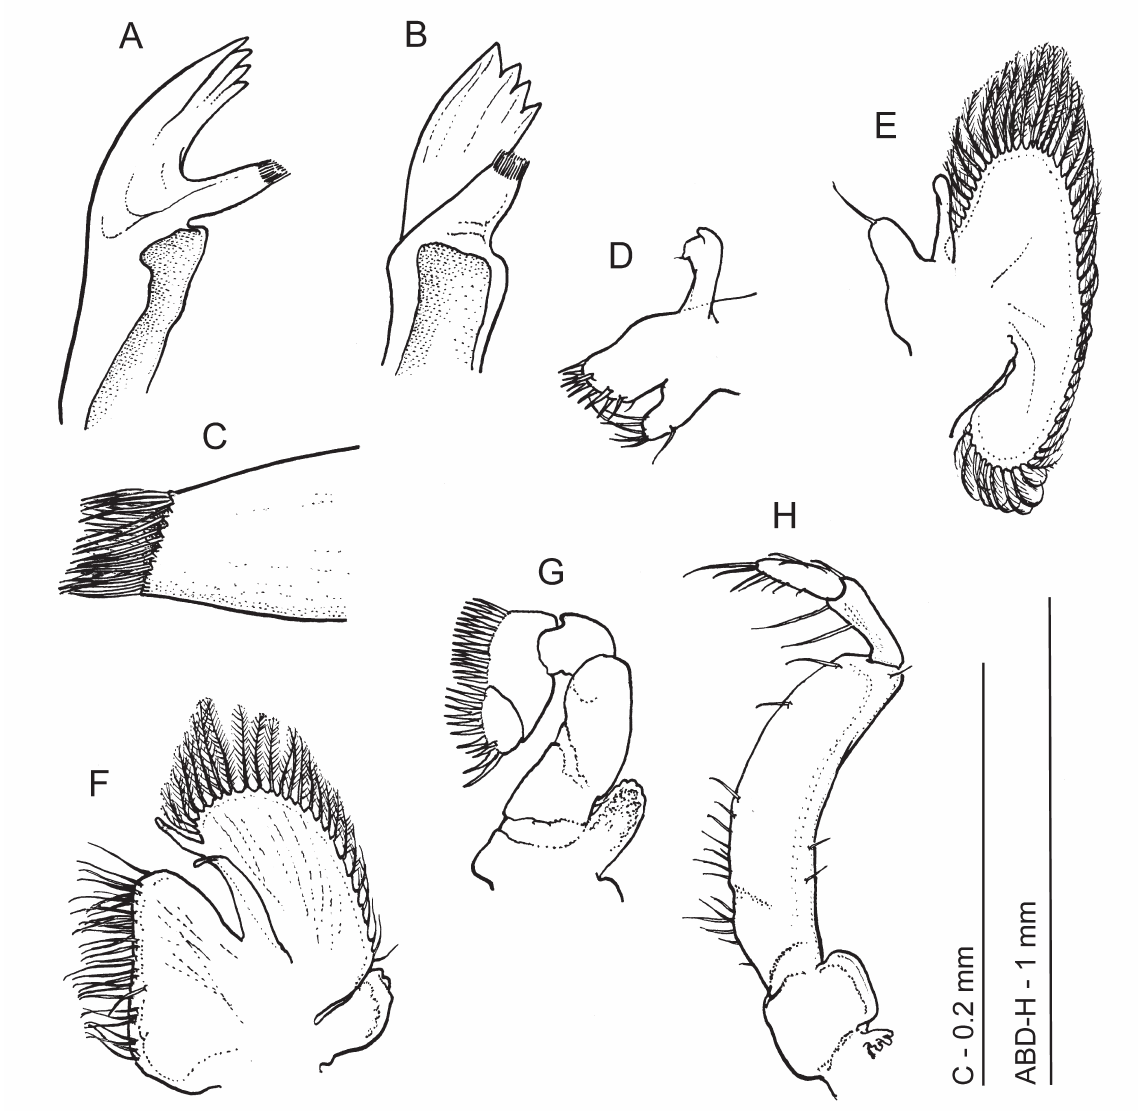
Fig. 4. Hamodactylus paraqabai sp. nov., ♀ , paratype (PoCL 1.6 mm, Madang, Papua New Guinea, MNHN-IU-2013-11090) , mouthparts. A . Mandible. B . Same as previous, turned. C . Same as previous, molar process. D . Maxillula. E . Maxilla. F . First maxilliped. G . Second maxilliped. H .